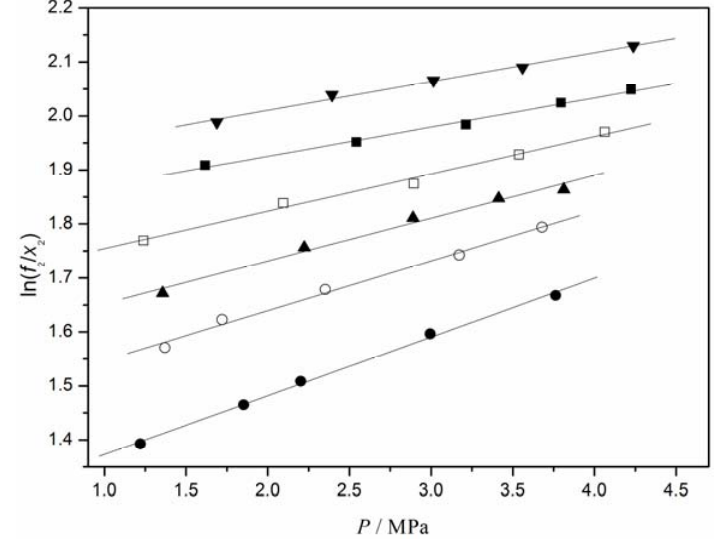
/x ) as a function of pressure at different temperatures: ( ● , 293.13 K; Figure 3. ln( f CO2 ○ , 303.13 K; ▲ , 313.15 K; □ , 323.15 K; ■ , 333.15 K; ▼ , 343.15 K), this work; The lines were calculated via linear